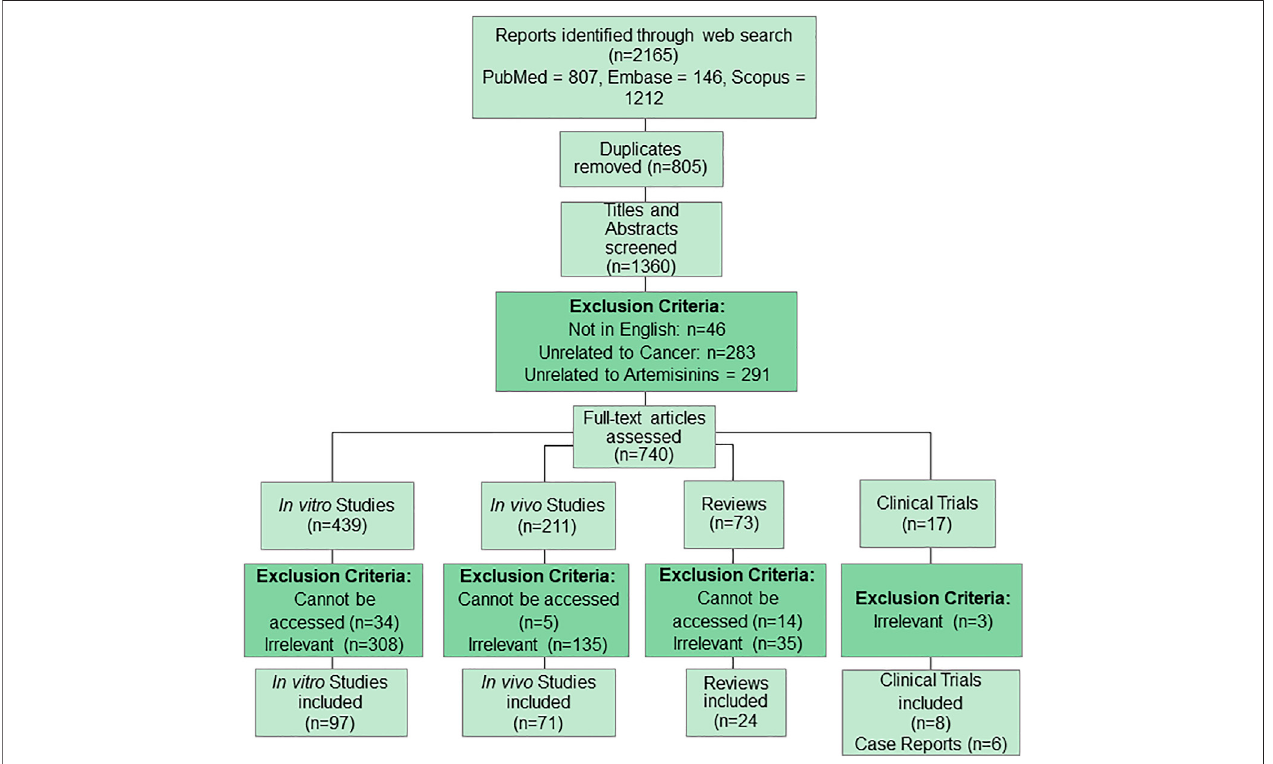
FIGURE 2 | Primary search strategy for anticancer properties of